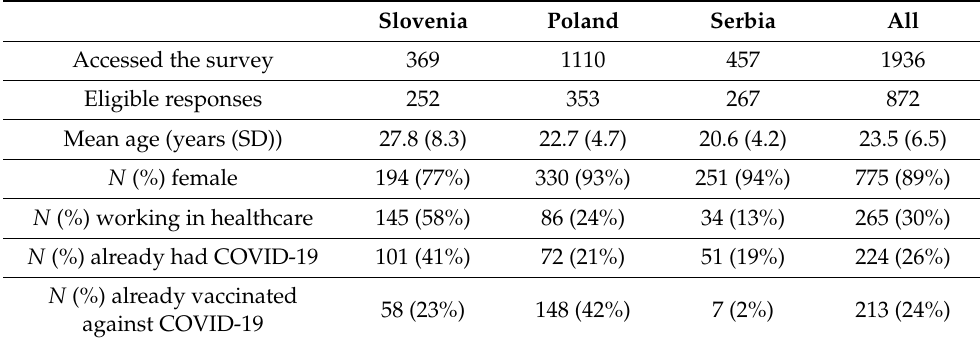
Table 1. Response rate and demographic data of included